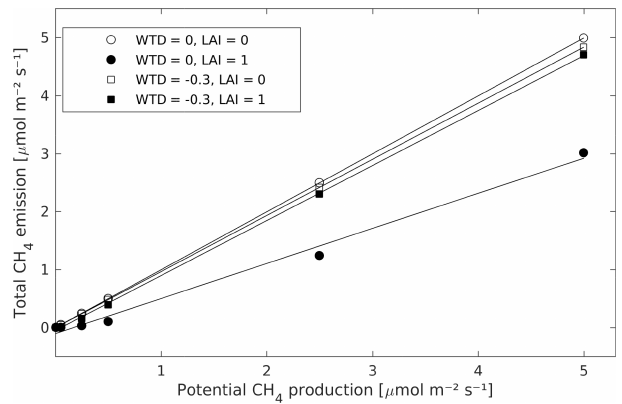
Figure 5. Dependence of the total output CH 4 emission on the po- tential CH 4 production rate in tests on the model sensitivity to input anoxic respiration, i.e., tests that were named starting with R_.